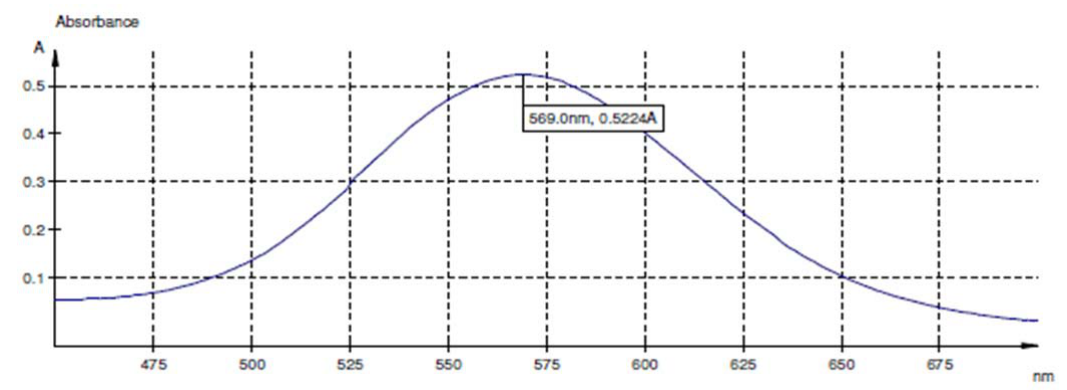
Fig. 4. UV spectrum of the test solution